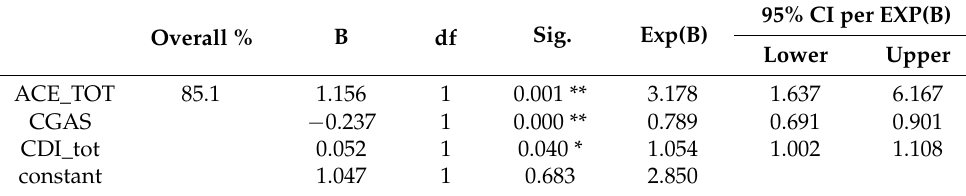
Table 6. Multiple Logistic